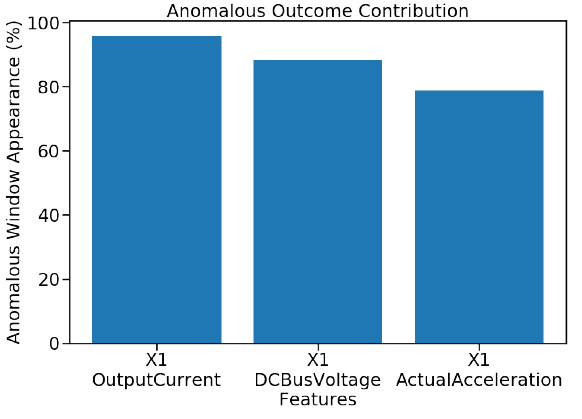
Figure 6. Anomaly root cause feature